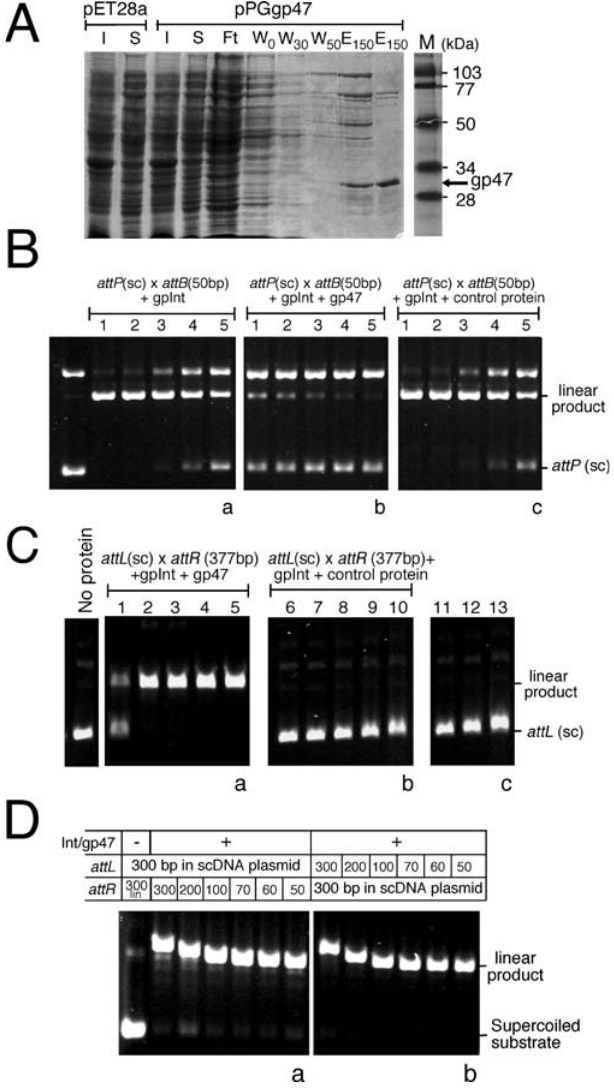
Figure 5. In Vitro Excisive Recombination Using